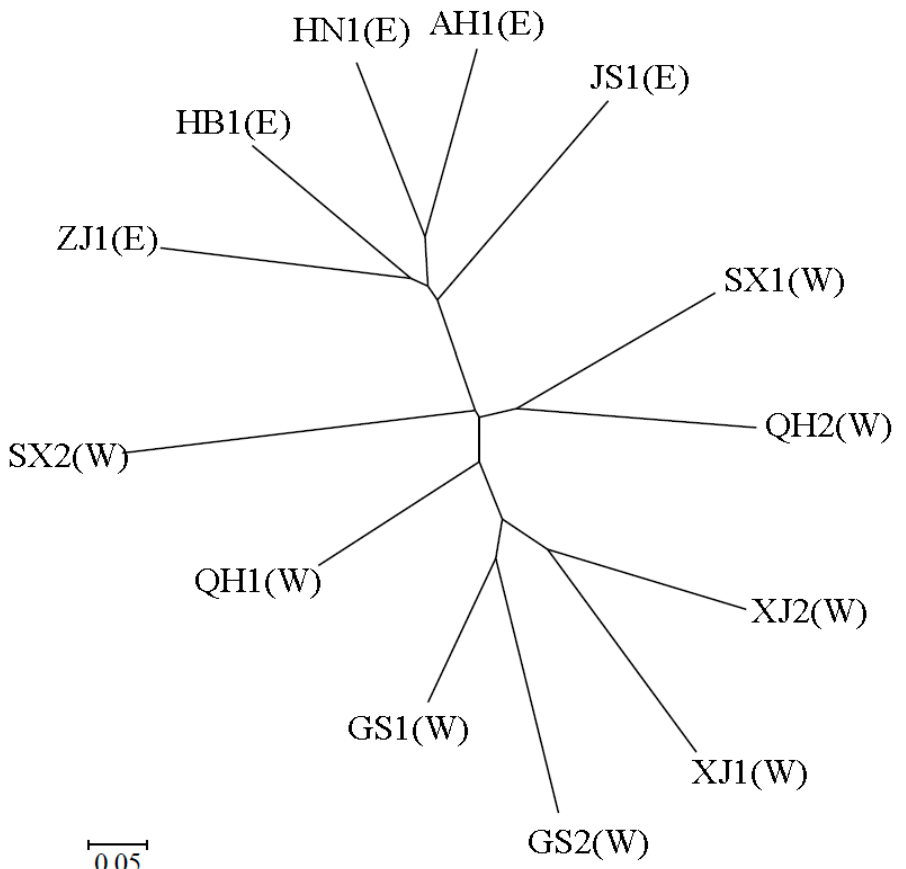
Figure 3. A neighbor-joining dendrogram of Sitobion avenae biotypes from nine provinces (AH1,